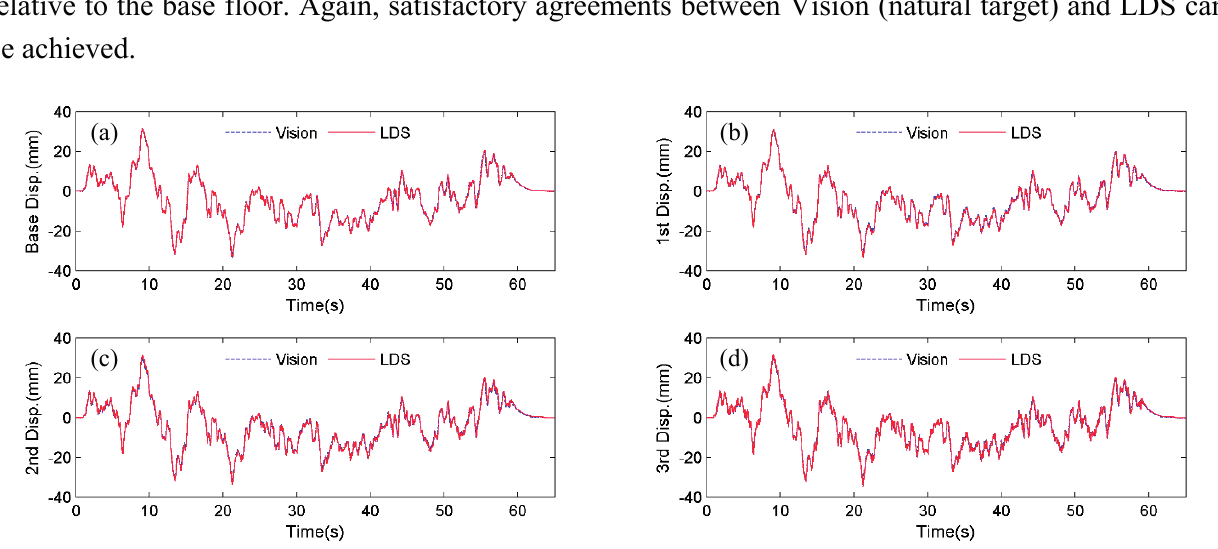
Figure 9. Displacement comparisons between Vision (natural target) and LDS: ( a )